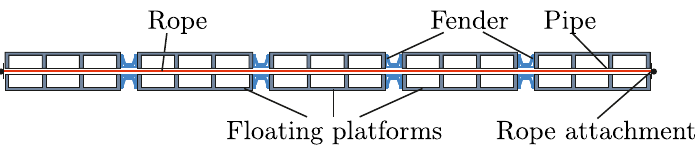
Figure 3. Schematic sectional view of five floating platforms connected by ropes and